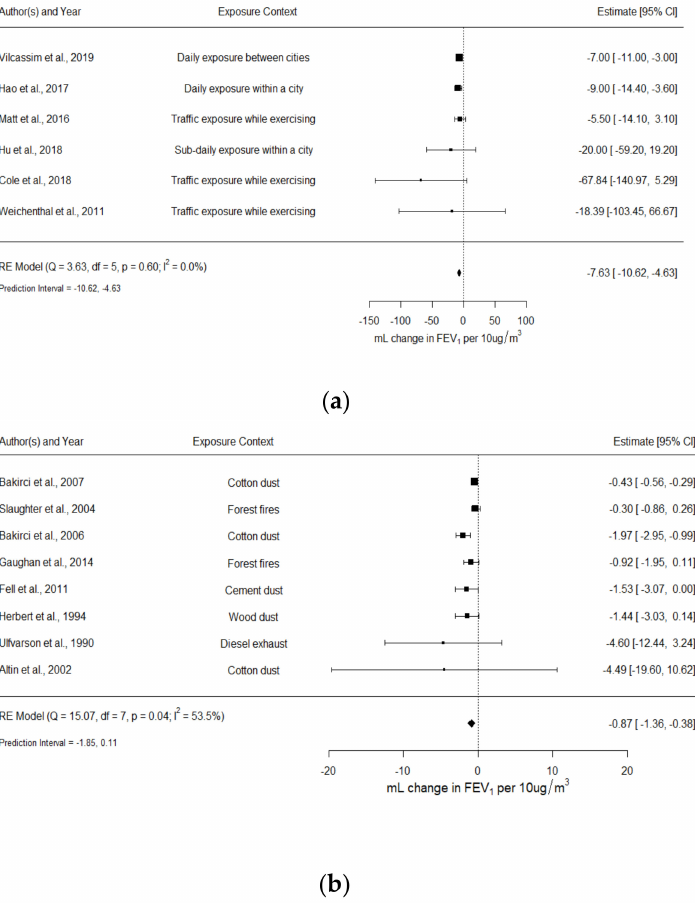
Figure 2. Forest plots of the association between ( a ) environmental PM 2.5 and FEV 1 (mL change); ( b ) occupational PM 4 and FEV 1 (mL changes). Random-effect meta-estimate of association is indi- cated by vertical point of diamond and 95% CI is represented by horizontal point. Squares represent individual effect size of primary studies and the bars the 95% CI; size of squares is proportional to weight in calculating random-effect summary estimates. Pooled effect sizes were estimated per 10 µ g/m 3 increase in exposure level. Daily exposure is defined as a 24 h exposure duration, while sub-daily is defined as an exposure duration <24